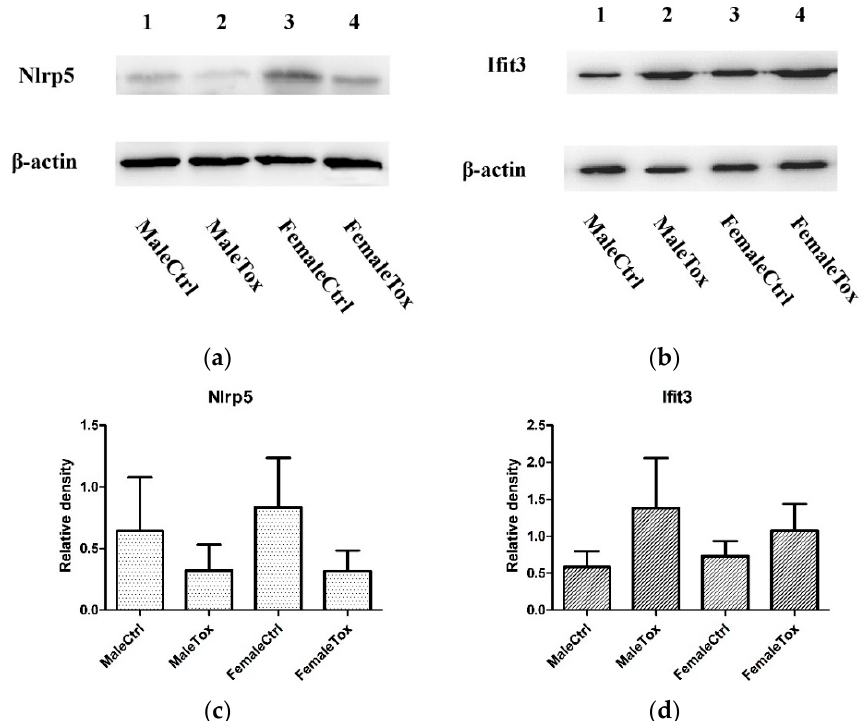
Figure 8. Trend of change in protein expression, detected by Western blotting. The figure shown the change trend of Nlrp5 and Ifit3 in testes and uterus during T. gondii infection. β -actin was used as controls. ( a , c ) shown the protein expression and relative density of Nlrp5 in each group; ( b , d ) shown the protein expression and relative density of Ifit3 in each group; Bar diagram shows changes in the relative density. Error bars represent SEM.